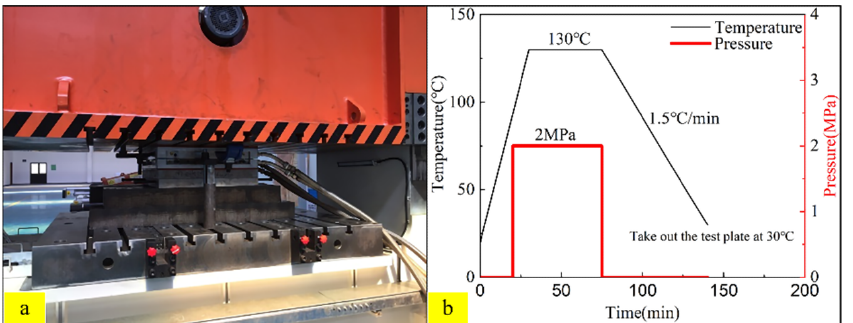
Figure 2. Moulding equipment and curing process parameters ( a ) Moulding equipment ( b ) Curing procedure with temperature and pressure parameters.